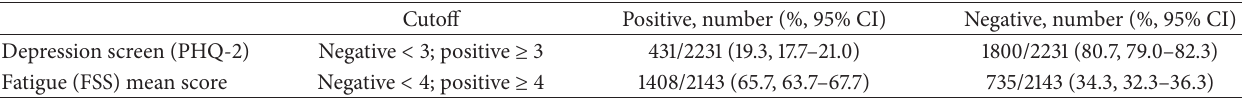
Table 8: Depression and fatigue screening.